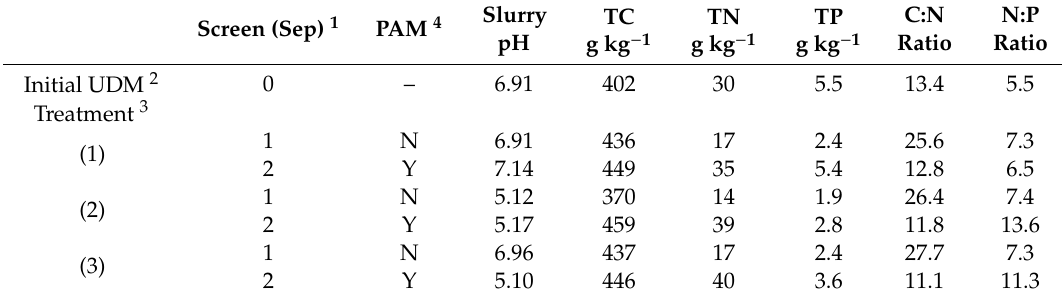
Table 2. Concentration of total C (TC), N (TN), P (TP), and N:P ratio on a dry basis in recovered dairy manure solids using a two-stage solid-liquid separation system with and without acid addition. Screen (Sep) 1 PAM 4